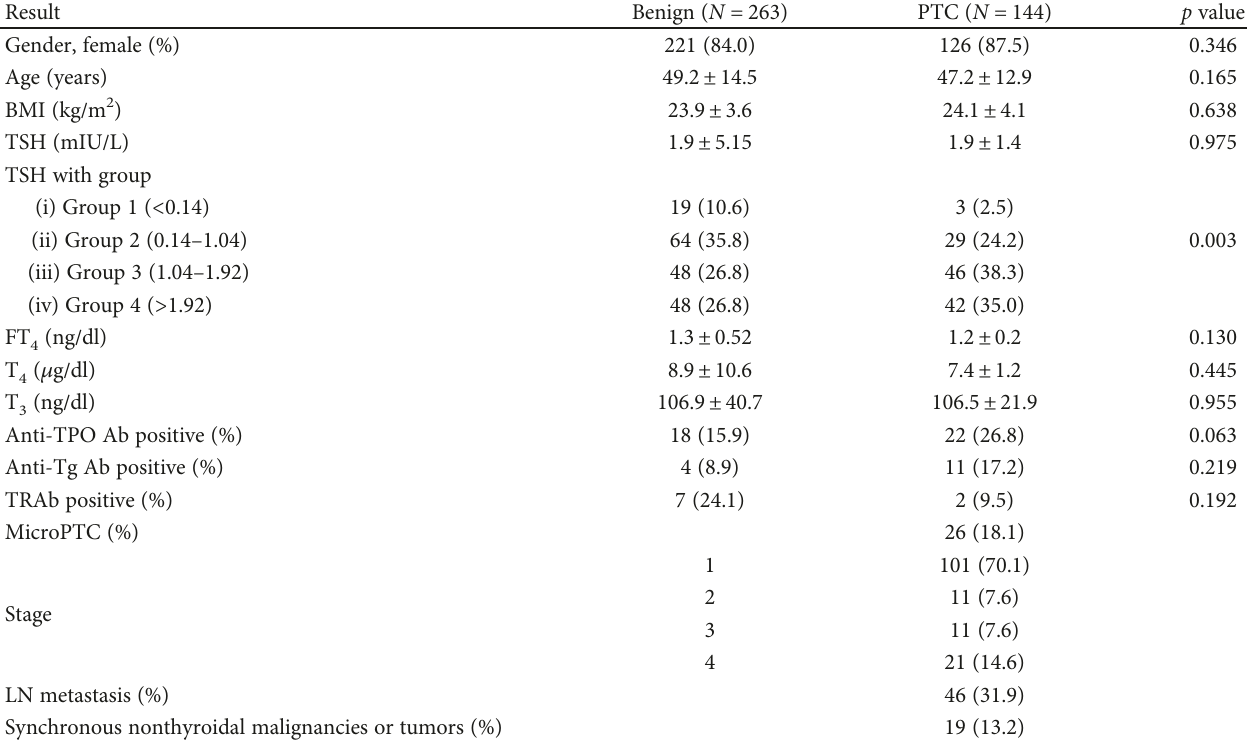
Table 4: Univariate analysis: related variables in patients with papillary thyroid cancer excluding those with Graves ’ disease who received